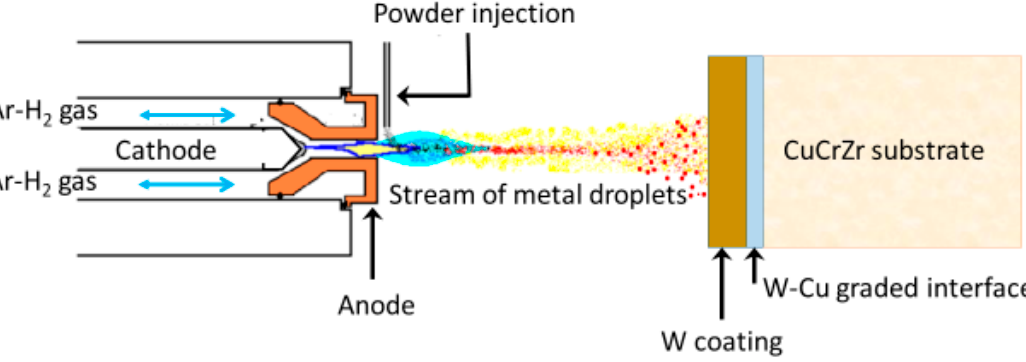
Figure 2. Schematic view of the PS apparatus.